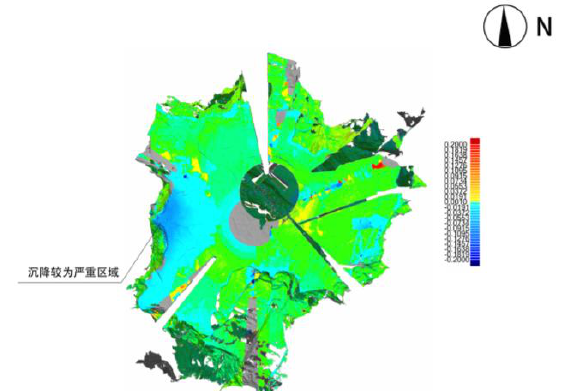
Figure.11 Comparative analysis chart of the first scan point cloud data and the fourth scan point cloud data. Blue area means the settlement in larger than other